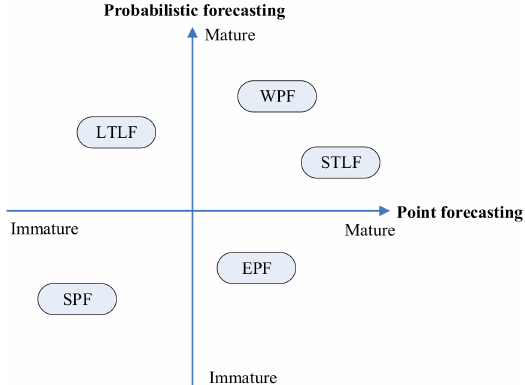
Figure 2. Maturity of energy forecasting